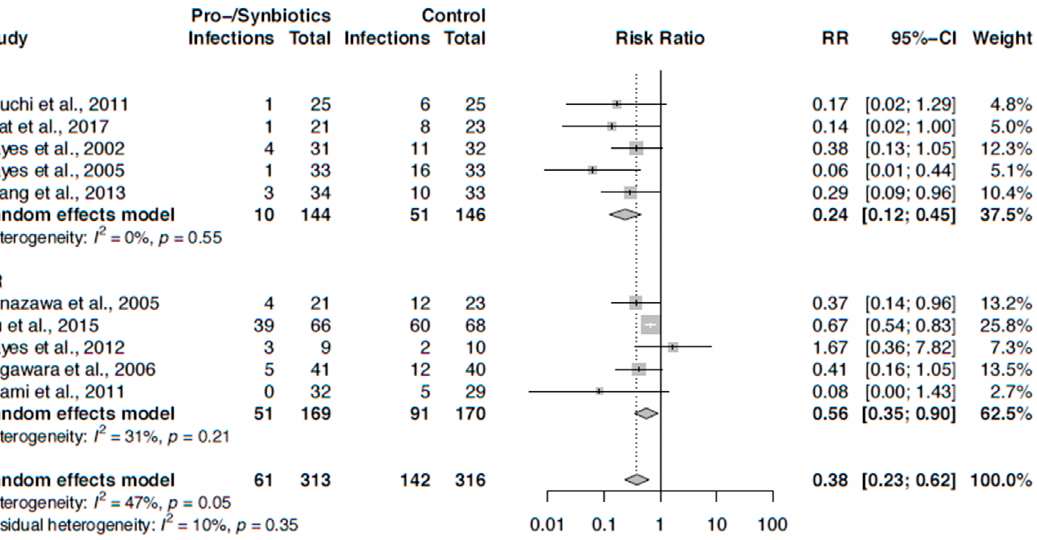
Figure 4. Forest plot of randomized controlled trials on perioperative pro-/synbiotics and their effect on infection stratified by type of surgery: liver resection (LR), liver transplantation (LT). A meta-regression for mean age of study participants and duration of supplementation, adjusted for type of surgery, showed no significant influence of these covariates ( p = 0.766 and p = 0.721,